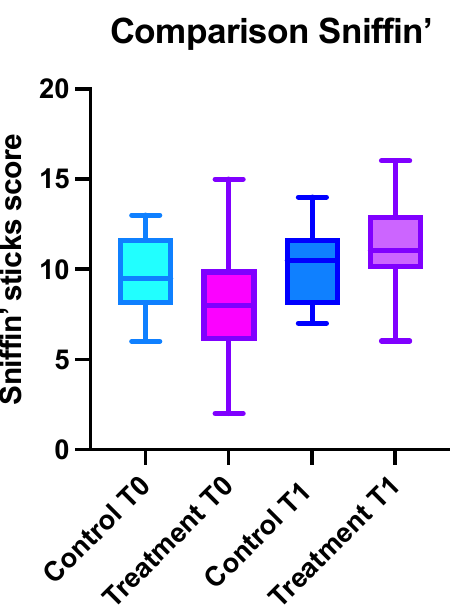
Figure 1. Comparison between the Sniffin’ Score at T0 and T1 both in the treatment group and in control group. A statistically significant difference was observed T0 and T1 in the treatment group (ANOVA: p < 0.0001; BH: p < 0.01), and between treatment and control group at T1 (HB: p < 0.05) but not statistically significant difference comparing the Sniffin’ score at T0 and T1 in the control (HB: p > 0.05).